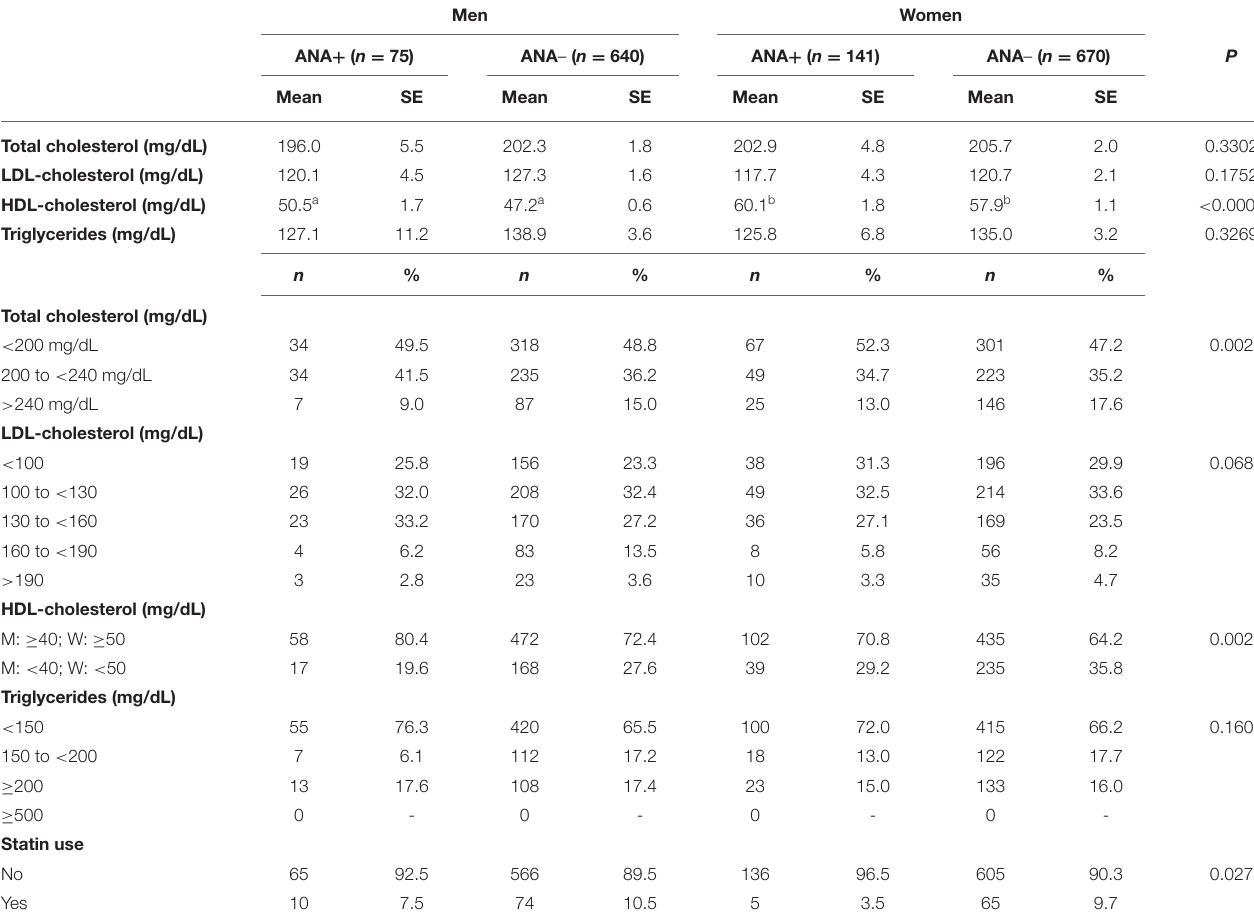
TABLE 2 | Distribution of serum lipids in ANA + and ANA– men and women in NHANES 1999–2004 ( n =